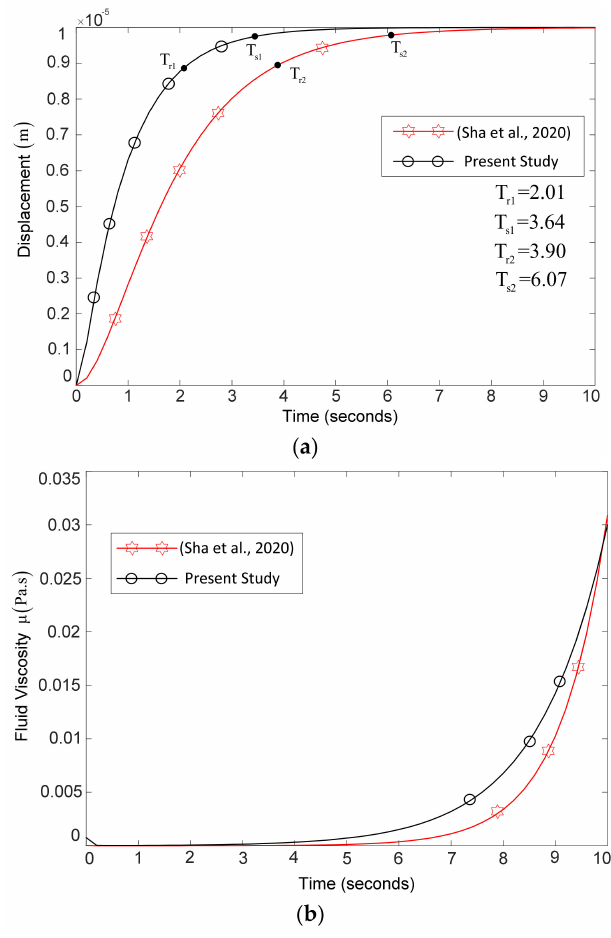
Figure 4. Control input (viscosity) and tracking performance. ( a ) Tracking performance to attain a